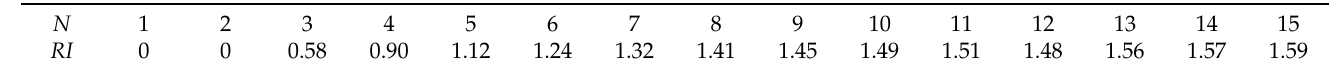
Table 3. Random consistency index (RI)